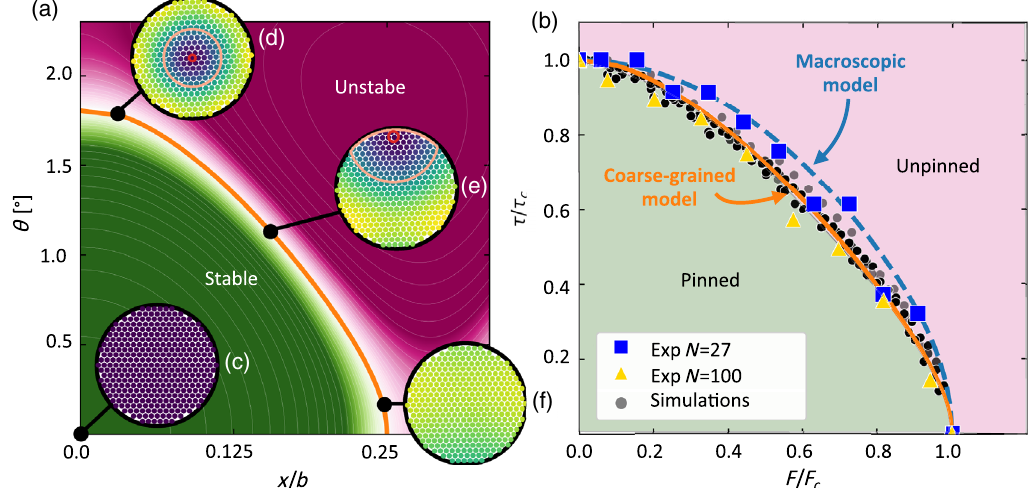
FIG. 4. Rotation-translation depinning boundary and its mechanism. (a) The calculated det H (color code) as a function of the center- 44 . 5 μ m) on a δ ¼ 0 surface. Green and pink regions correspond of-mass rotation θ and translation x , for a cluster with N ¼ 363 ( R cl ¼ to det H > 0 and det H < 0 , respectively. The orange line marks the det H ¼ 0 depinning boundary. (b) The measured ð τ ; F Þ pairs for c two experimental clusters with N ¼ 27 and N ¼ 100 on a δ ¼ 1 . 1% surface (squares and triangles), and for simulated clusters with a range of sizes (from N ¼ 15 to 5000) and shapes (circular, hexagonal) on a δ ¼ 0 surface (dots). The force in experiments is achieved by tilting the sample at an angle α , which applies gravitational force F ¼ mg sin α to colloidal particles of buoyant weight mg [30,31]. In both experiments and simulations, to measure the ð τ ; F Þ pairs, we apply a force F in the x direction and then gradually increase the c torque τ until the cluster depins. All simulation points collapse near the stability-boundary line (solid), obtained within the coarse- grained model. (c) – (f) Snapshots of the N ¼ 363 simulated circular cluster shown in (a) at four different coordinates ð θ ; x Þ indicated by the corresponding linked dot. The colloids are color coded according to the substrate potential as in Figs. 1(e) – 1(h), showing the moir´e- pattern evolution when the cluster coordinates